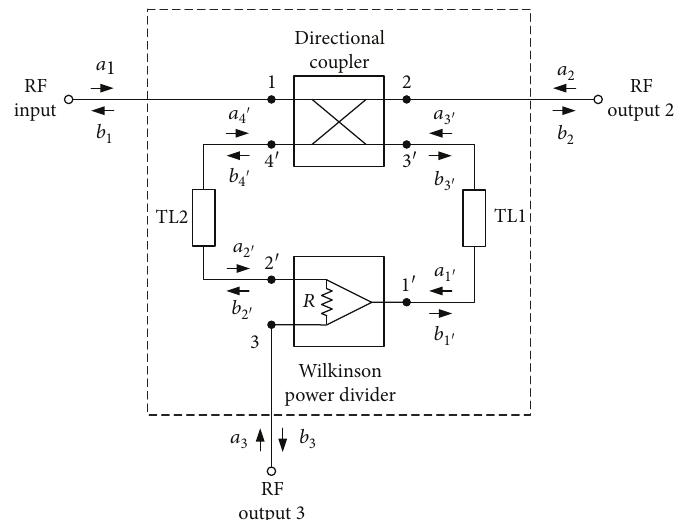
Figure 2: Schematic of the three-port divider with a feedback